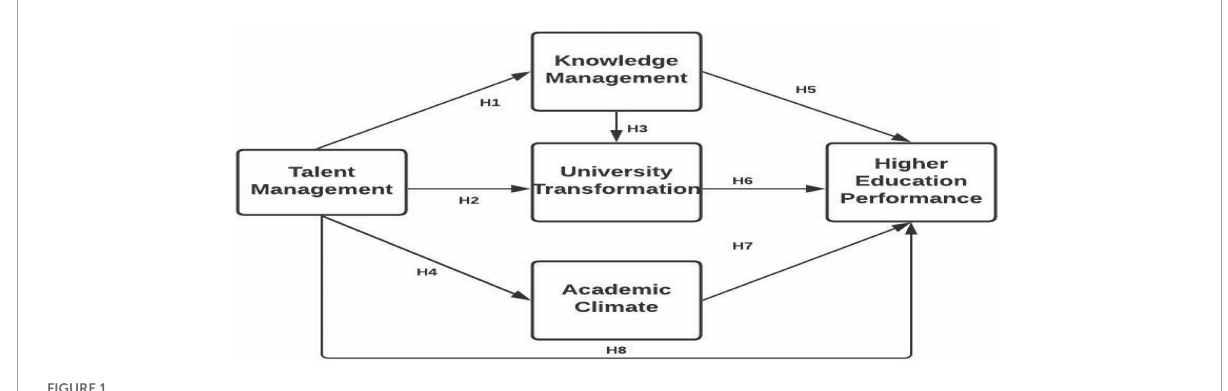
FIGURE1 Conceptual model of the